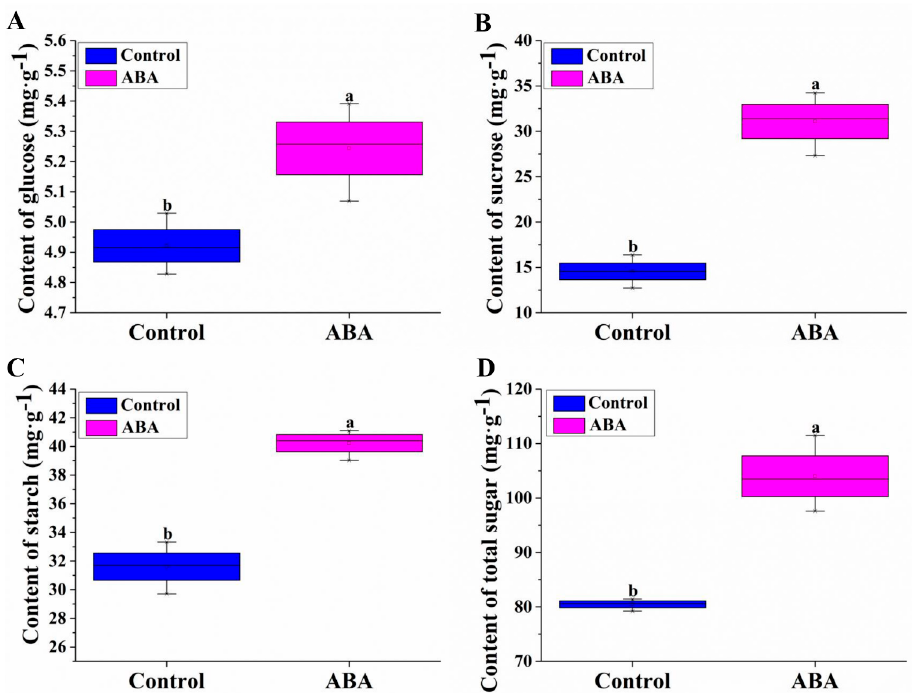
Figure 1. Effects of exogenous 0.05 μ M ABA on glucose ( A ), sucrose ( B ), starch ( C ) and total sugar ( D ) contents in hypocotyls of cucumber. The values (means ± SE) are the averages of the three independent experiments. The different letters above the bars indicate significant differences ( p < 0.05) according to one-way ANOVA and t test.